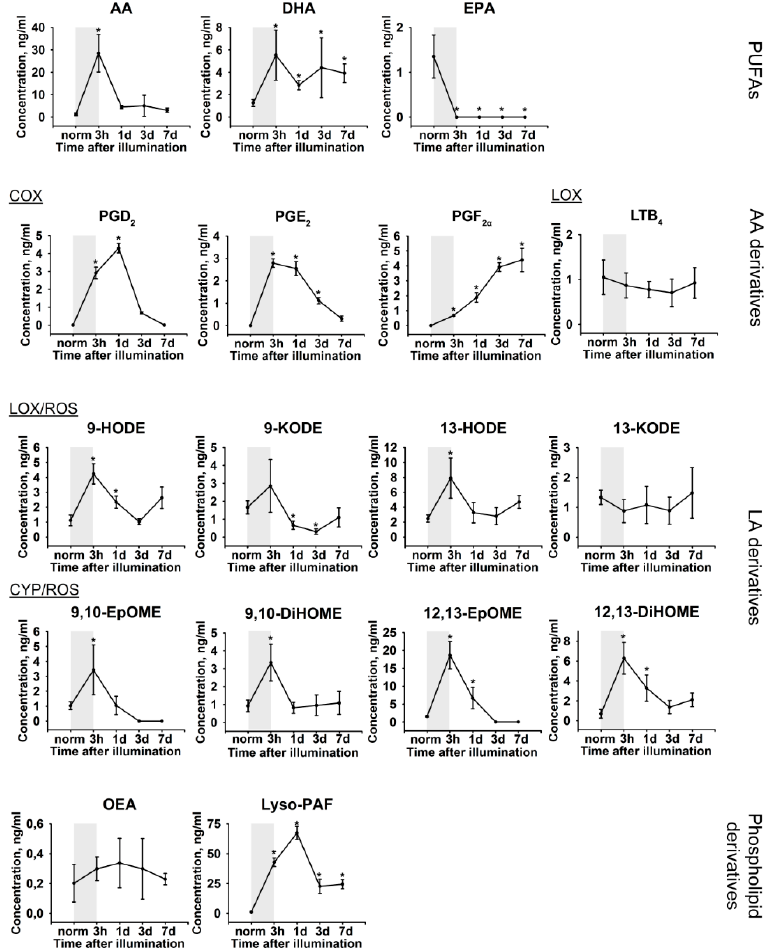
Figure 4. Alterations in patterns of lipid mediators in rabbit AH under conditions of LIRD. The animals were illuminated with intense visible light (30,000 lx) for 3 h (the course of the illumination is